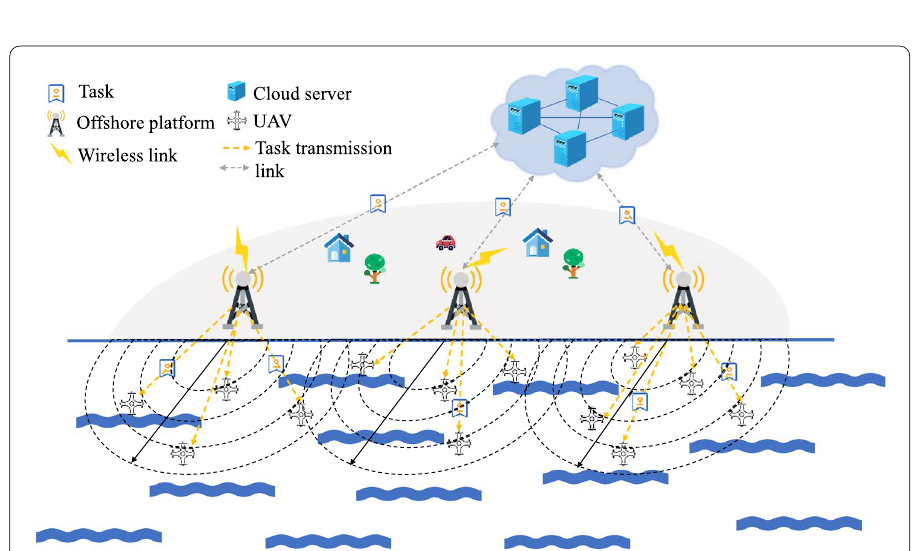
Fig. 1 Schematic diagram of the intelligent ocean control